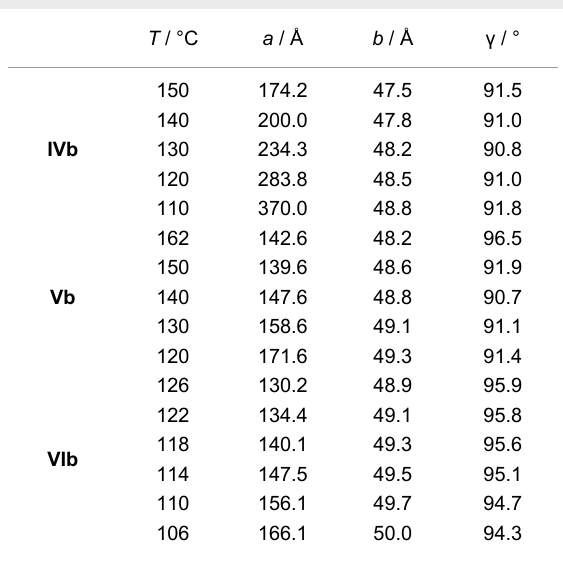
Table 2: Parameters of the crystallographic unit cell, measured by X-ray in the B 1Rev phase for several compounds at selected tempera- tures, T